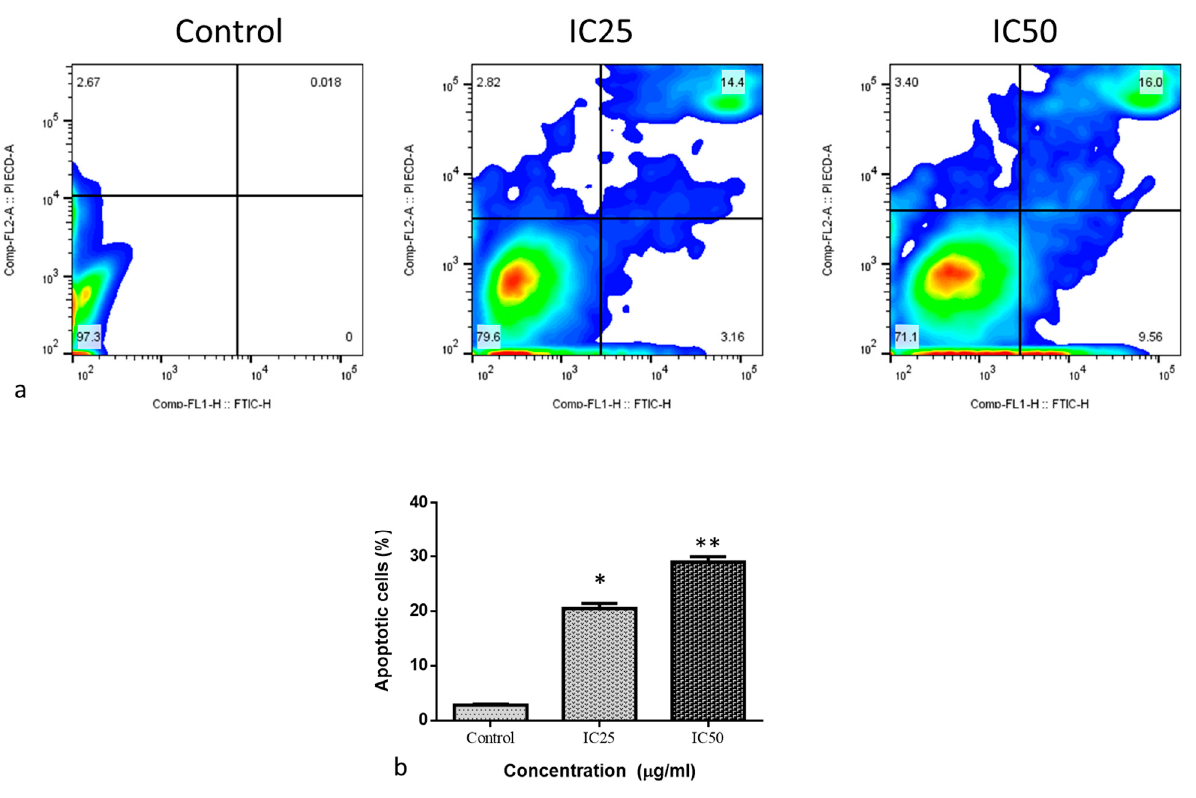
Figure 5. Cell cycle analysis was performed using fl ow cytometry after staining with Propidium Iodide (PI). Albumin and visnagin NPs were administered to MDA-MB-468 cells at IC50 concentra- tions for 48 h compared with controls. An analysis of cell cycle pa tt erns and apoptosis distribution in untreated or control ( a ) and albumin and visnagin NP-treated cells, and their concentrations of IC25 ( b ) and IC50 ( c ). Percentage of cell cycle distribution ( d ). (* signi fi es p < 0.05 when compared with control, ** signi fi es p < 0.001 when compared with control).